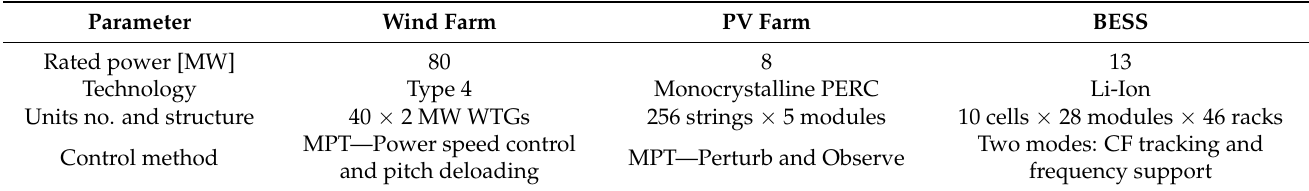
Table 3. Main parameters are ratings of the WF, PVF and the BESS.